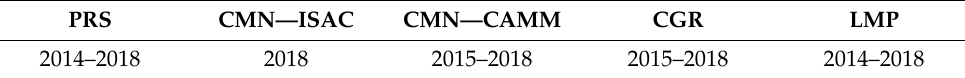
Figure 1. Geographical location of the measurement sites considered in this work. Plateau Rosa (PRS), Mt. Cimone (CMN), Capo Granitola (CGR) and Lampedusa (LMP). Table 1. Measurement period considered in this study for each